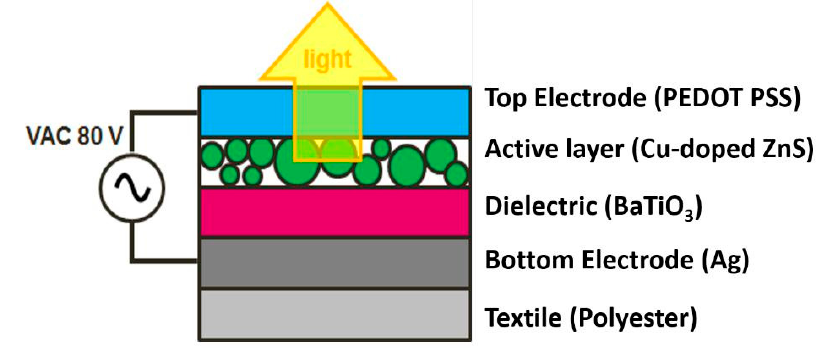
Figure 8. Build-up of the ACPEL technology.